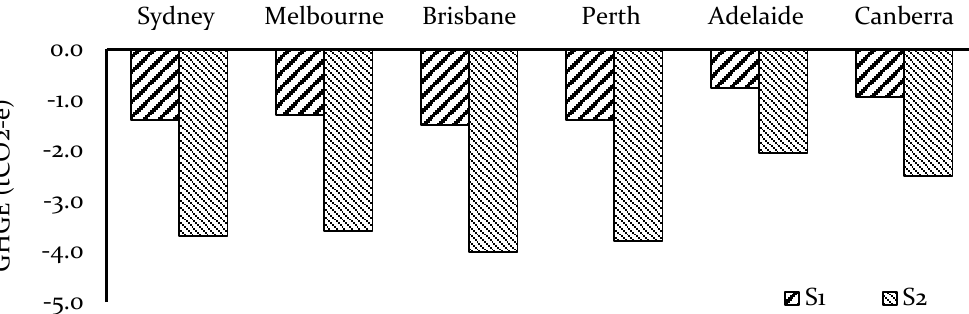
higher energy consumption for a lower workforce number compared to other cities.